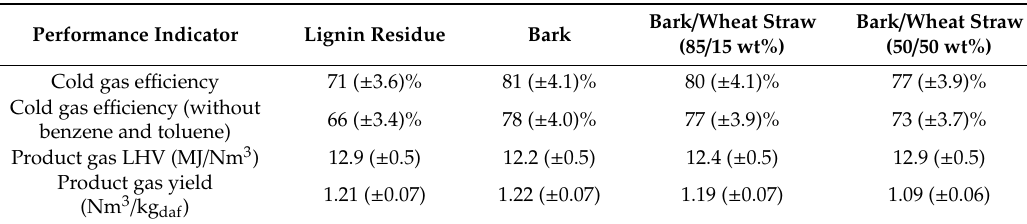
Table 3. Cold gas e ffi ciency, lower heating value (LHV) and yield of product gas for each feedstock (all gas species considered except if